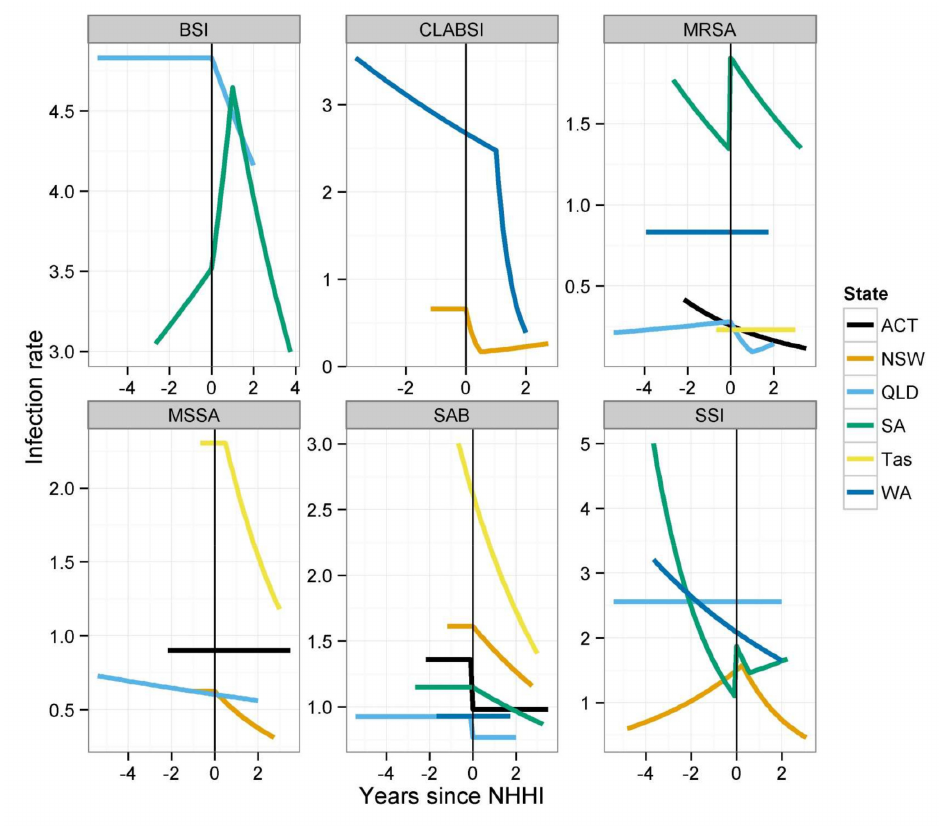
Fig 3. Estimated mean change in infection rates after the intervention in each state/territory. Results from the best fitting regression model in each state/territory, reproduced from Barnett et al . [23]